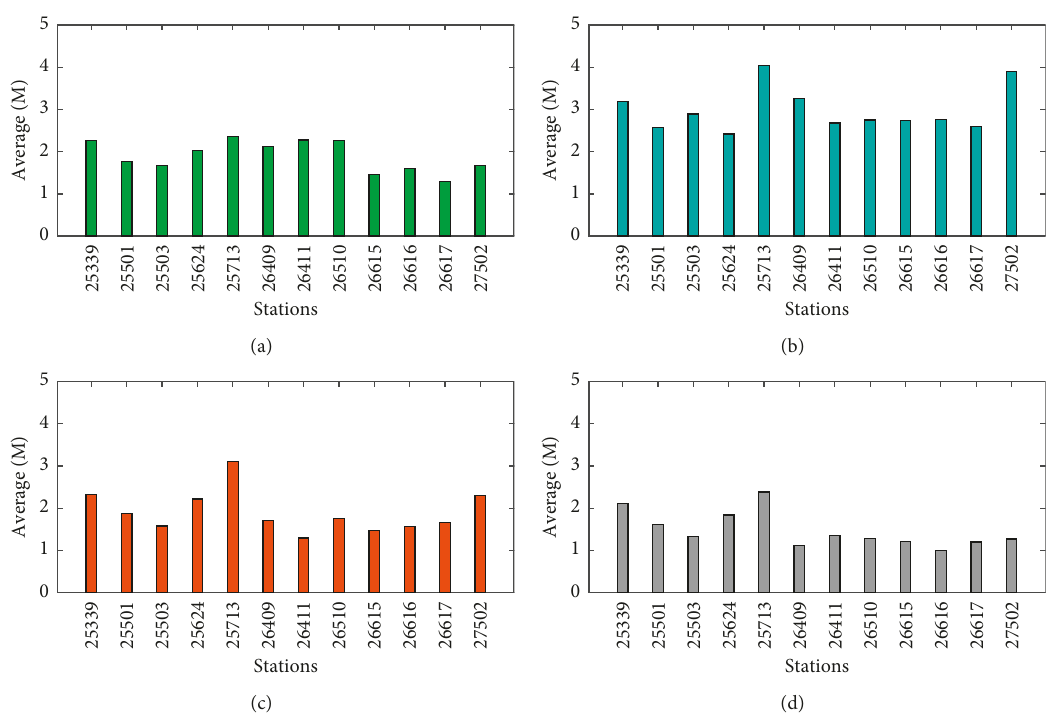
Figure 9: Seasonal average intensity (M) distributions of elevation ducts at 12 stations in Alaska: (a) spring; (b) summer; (c) autumn; (d) winter.